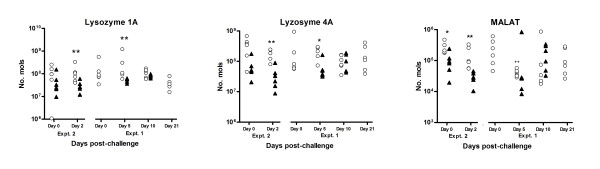
Results of competitive multiplex qRT-PCR analysis to investigate temporal changes in the expression levels of transcripts for lysozymes 1A and 4A, and MALAT, as indicated, throughout the experiment trials summarised in Table 1. Open circles represent data from naïve sheep; closed triangles represent data from immune ("previously infected") sheep. Significant difference between Nv and Im at same timepoint; *P ≤ 0.05, **P ≤ 0.005, ***P ≤ 0.005; Significant difference between timepoint and day 0 of same group (where available); +P ≤ 0.05, ++P ≤ 0.005, +++P ≤ 0.005 (Mann-Whitney U-test for non-parametric data).